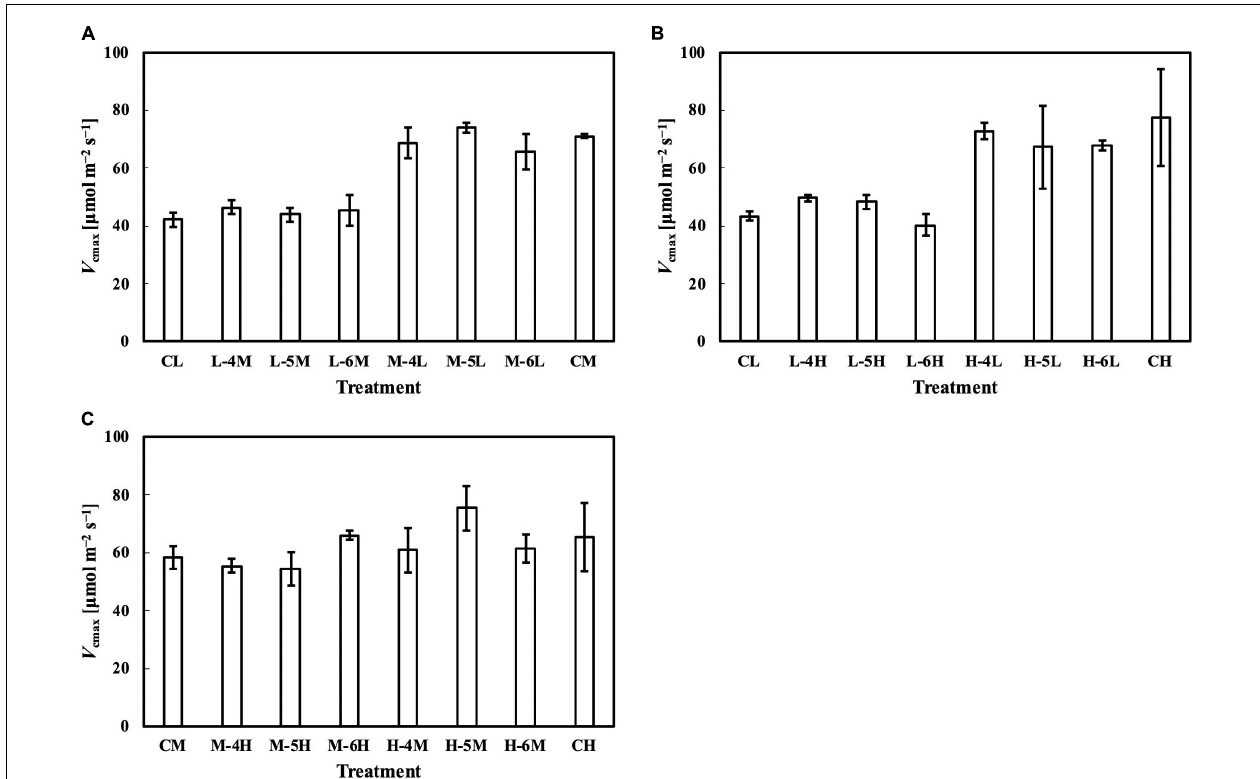
FIGURE 9 | V cmax of leaves subjected to a PPFD for 1 day different from the basal PPFD in the other days. CL and CM: treatments with a constant PPFD of 100 and 400 µ mol m − 2 s − 1 , respectively. The experiment was divided into three groups (A–C) and conducted separately due to limited experimental capacity. Values were means ± standard errors ( n = 3). L–4M: treatment with a PPFD of 400 µ mol m − 2 s − 1 in the fourth day of treatment period and a basal PPFD of 100 µ mol m − 2 s − 1 in the other 5 days. See Supplementary Table 2 for details of treatments.